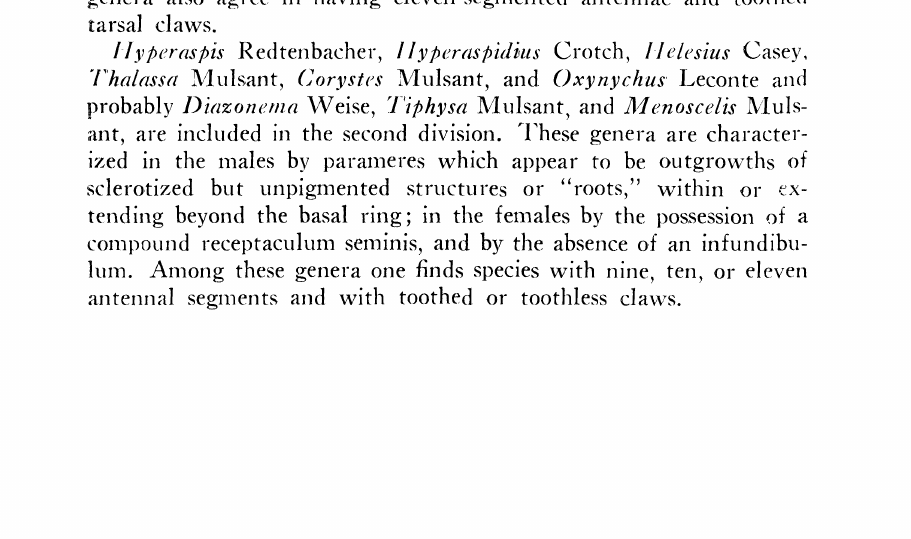
Figure 1. Brackyacantha dentipes (Fabricius). A. Aedeagus (without sipho) B. Sipho- C. Femal, genitalia, showing receptaculum seminis, sperm duct, infundibulum, and apex of